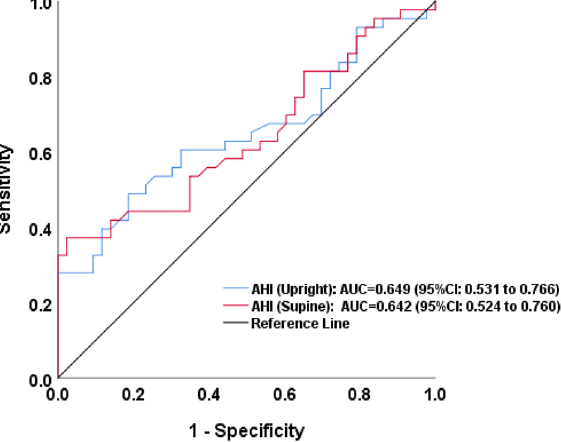
Figure 1. ROC curve of the AHI measurement from upright and supine radiographs.